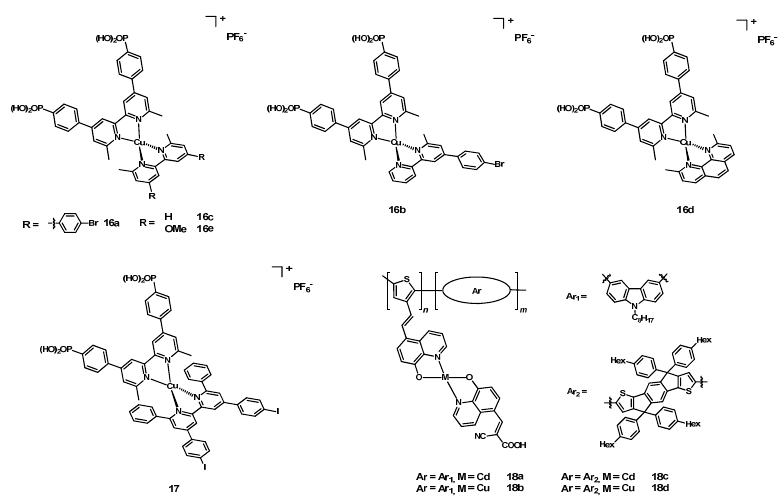
Figure 9. Structure of dyes 16a – e , 17, and 18a – d